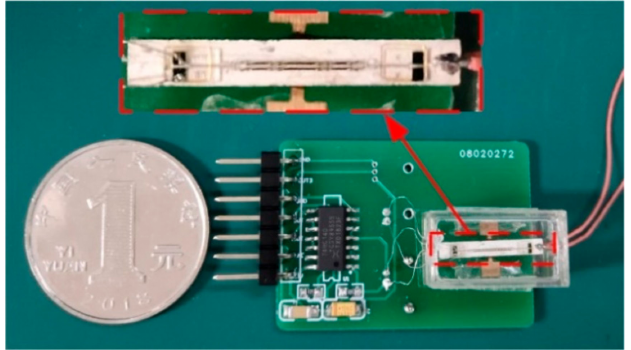
Figure 5. Photograph of the composite sensor with the gate oscillator